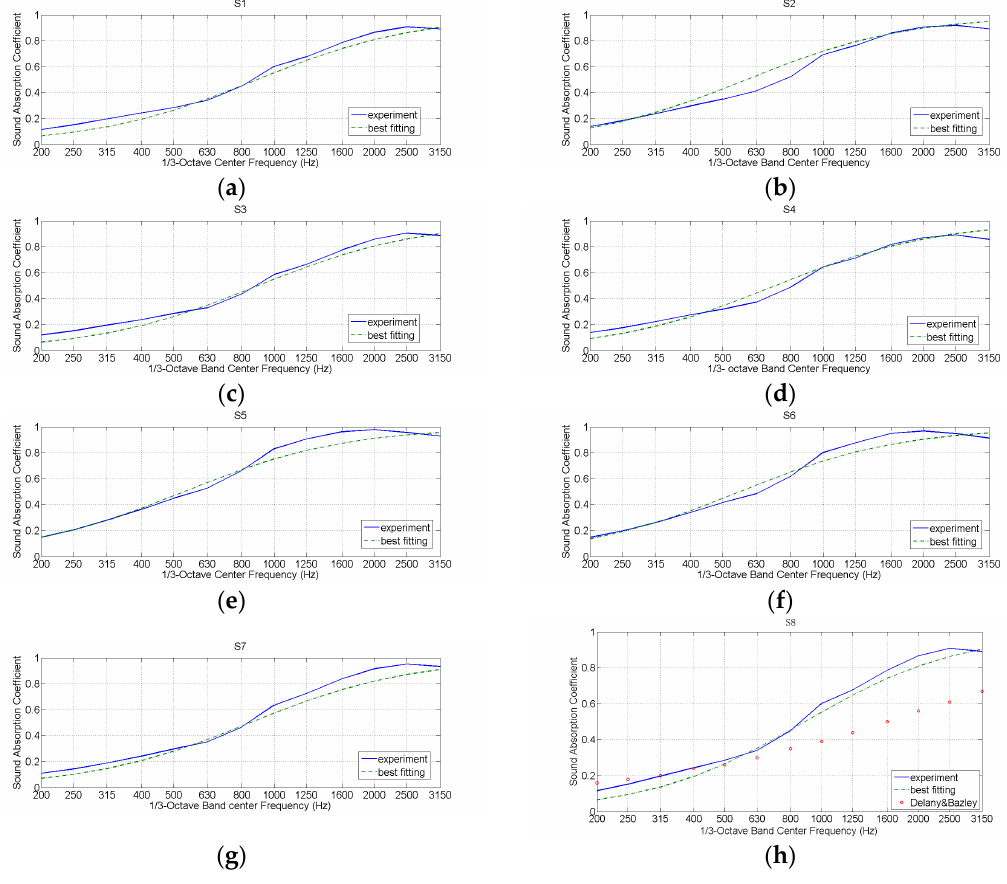
Figure 8. Best-fit curves for the different sheep wool samples measured in this paper. ( a ): sample S1; ( b ): sample S2; ( c ): sample S3; ( d ): sample S4; f; ( e ): sample S5; ( f ): sample S6; ( g ): sample S7 and ( h ): sample S8.